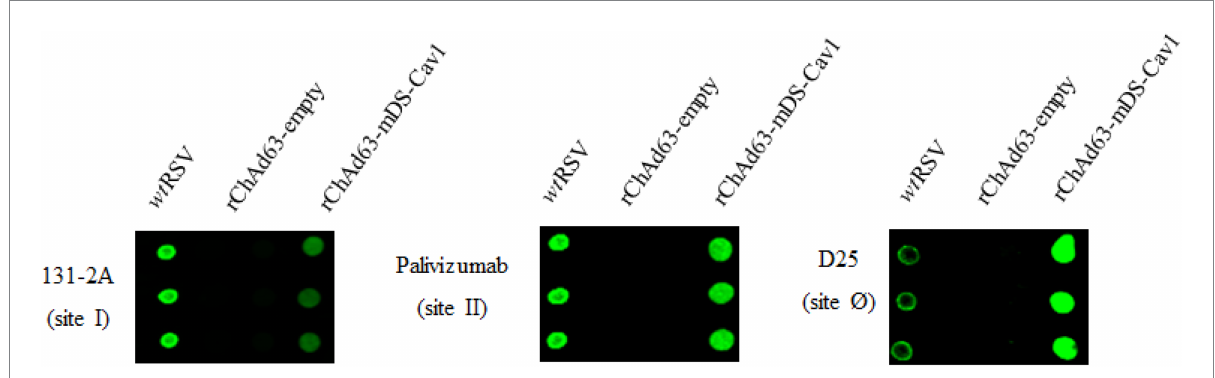
FIGURE 1 In vitro characterizations of the encoded preF from rChAd63-mDS-Cav1. After 48 h following infection with rChAd63-mDS-Cav1, HEK293 cells were collected and Dot blot assay was performed. The prefusion epitope Ø in the expressed preF by rChAd63-mDS-Cav1 was detected